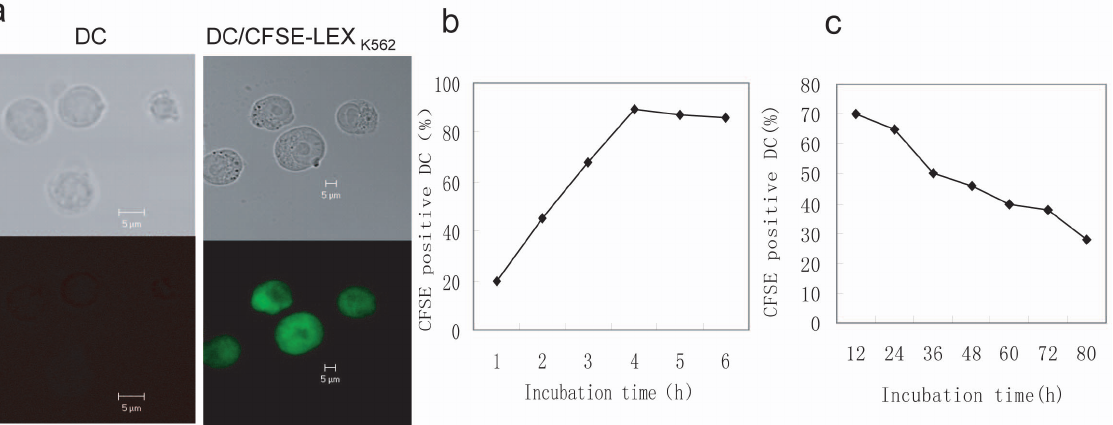
Figure 2. Exosome-uptaking by dendritic cells (a) Carboxyfluorescein succinimidyl ester (CFSE)-labeled exosomes were co-cultured invitro with dendritic cells (DCs), and CFSE-positive DCs were detected using flow cytometry at different times during the culture. Confocal microscopy was used concurrently with flow cytometry to visualize the cultured DCs. (b) Phase changes of CFSE expression in DCs at different time points during the culture. (c) To investigate the rate of decay of exosomes (EXOs) in DCs, DCs were incubated with CFSE-labeled EXOs for 4 h, washed twice with phosphate-buffered saline, cultured in culture medium, and examined at different time points for up to 72 h.